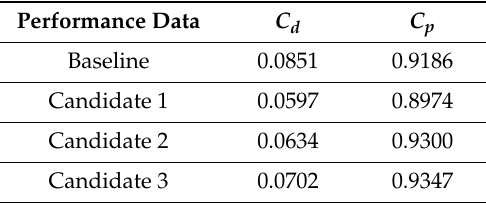
Figure 7. Optimization results: Pareto solutions. Table 2. Optimization results: Pareto solutions.